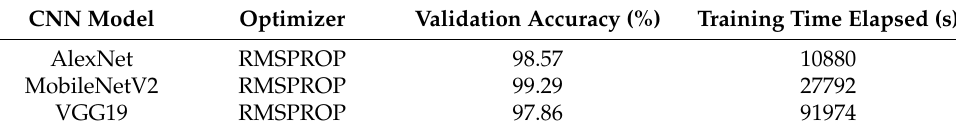
Table 3. Performance comparison between the pretrained CNN models.